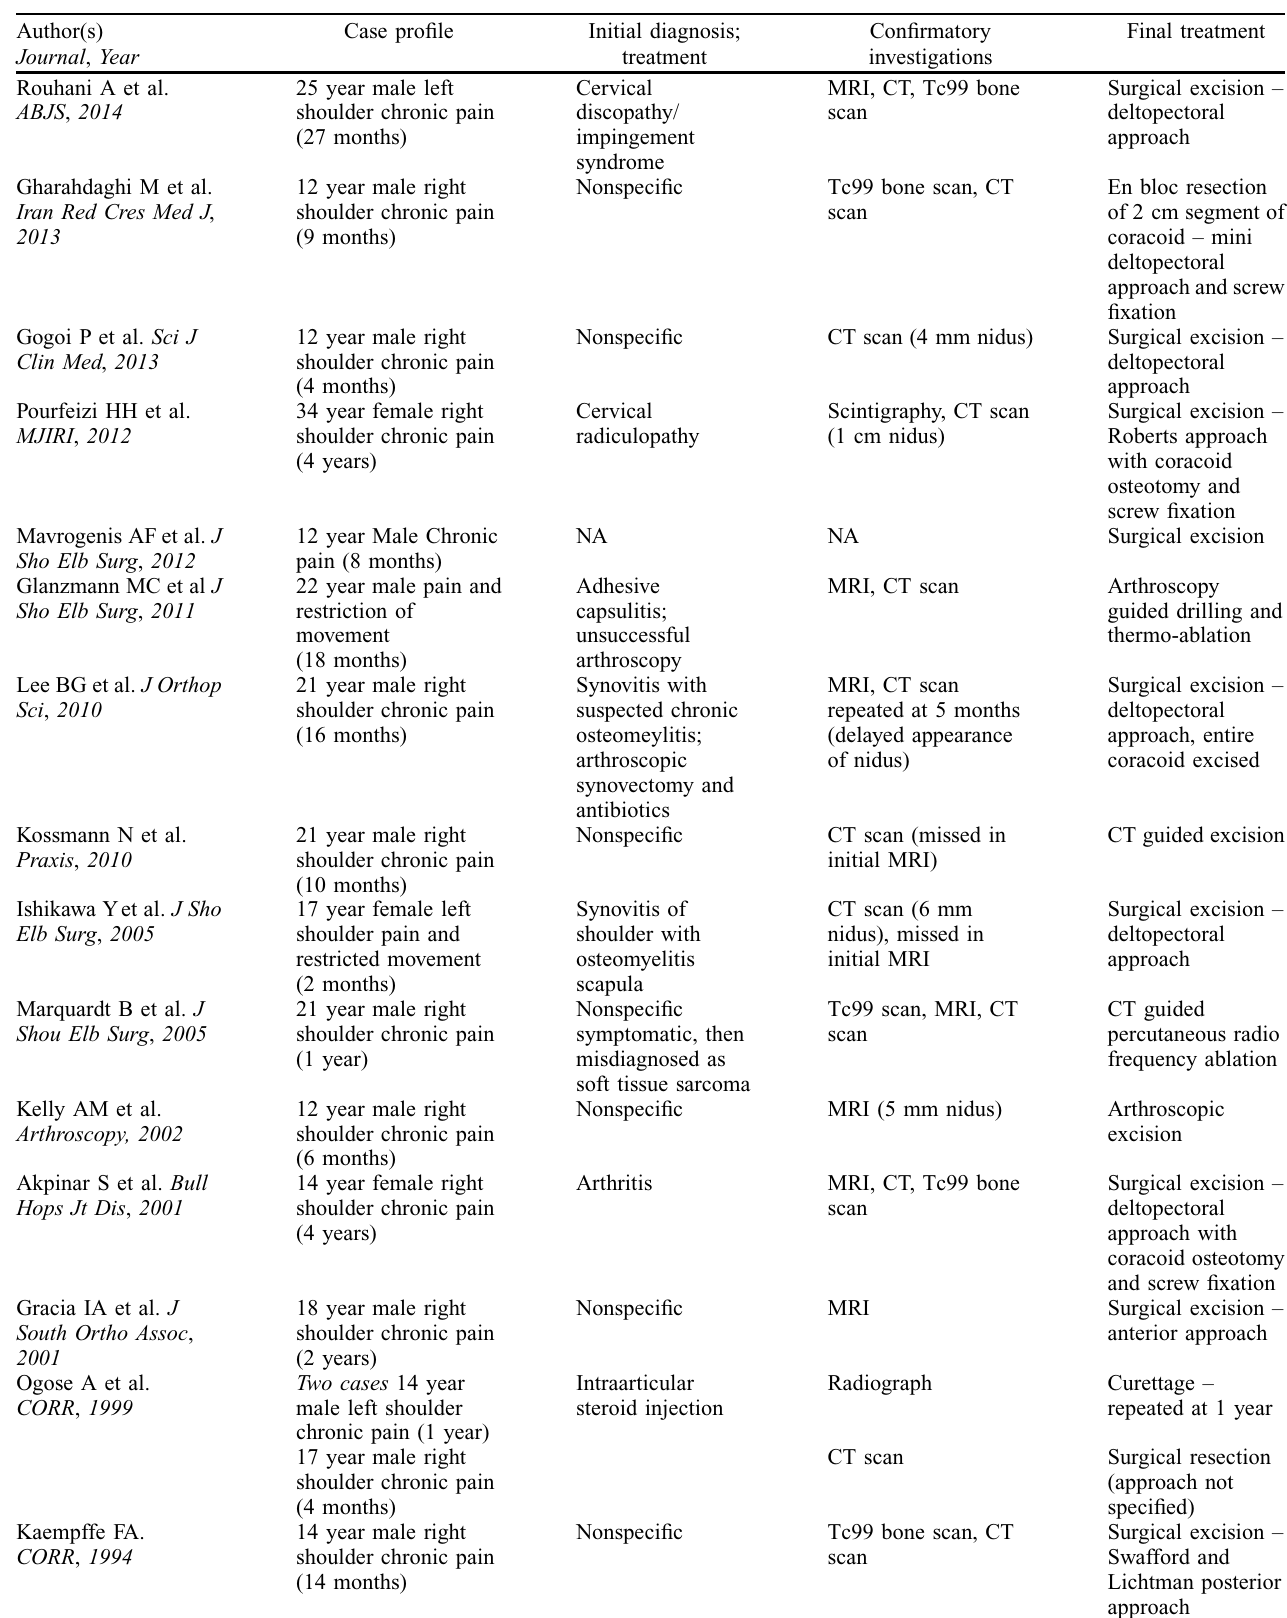
Table 1. Summary of cases reported in the literature